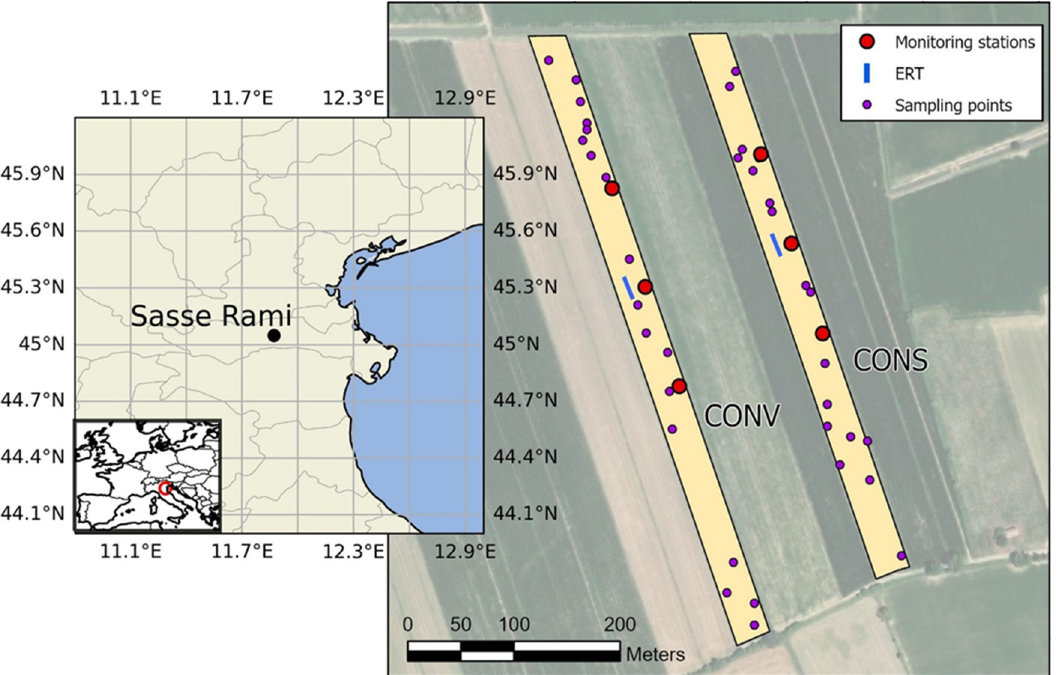
Figure 1. The Sasse-Rami experimental farm location and zoom to the CONV and CONS fields. Table 1. Main soil physical and chemical characteristics (top 50 cm) of the experimental farm. Characteristic